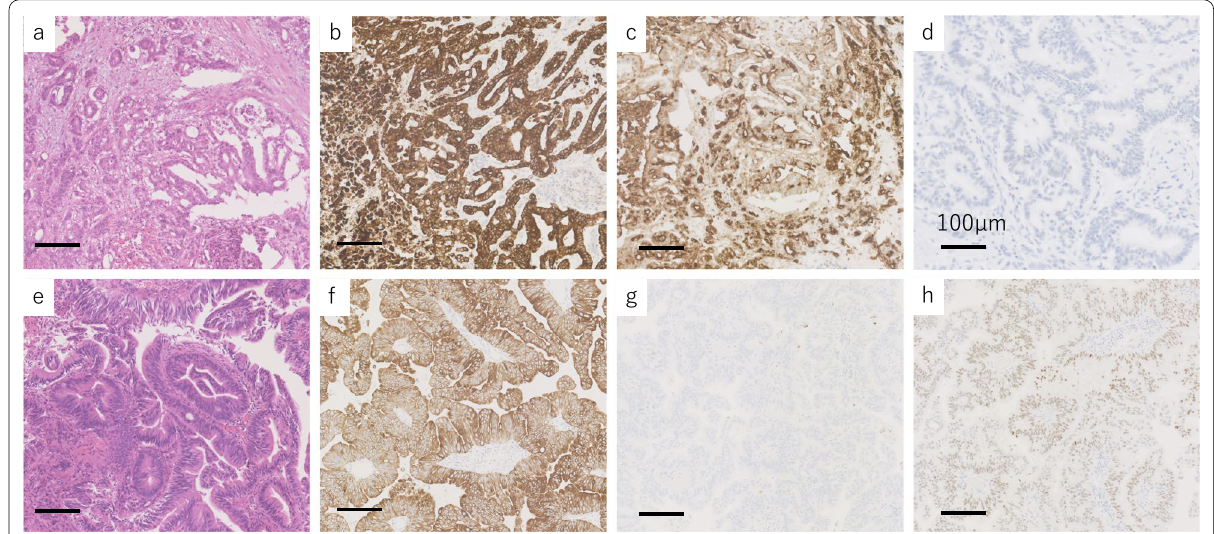
Fig. 5 Pathological examinations of primary and metastatic tumors. Histopathological appearance of pancreatic ductal carcinoma ( a – d ) and metastatic brain tumor ( e – h ). Pancreatic tumor shows duct-like glandular structures ( a ). Metastatic brain tumor resembles intestinal columnar cells ( e ). Both tumors are CK19 positive ( b , f ). Pancreatic cancer is MUC1 positive; metastatic brain tumor is negative ( c , g ). Metastatic brain tumor is CDX2 positive; pancreatic cancer is negative ( d , h )